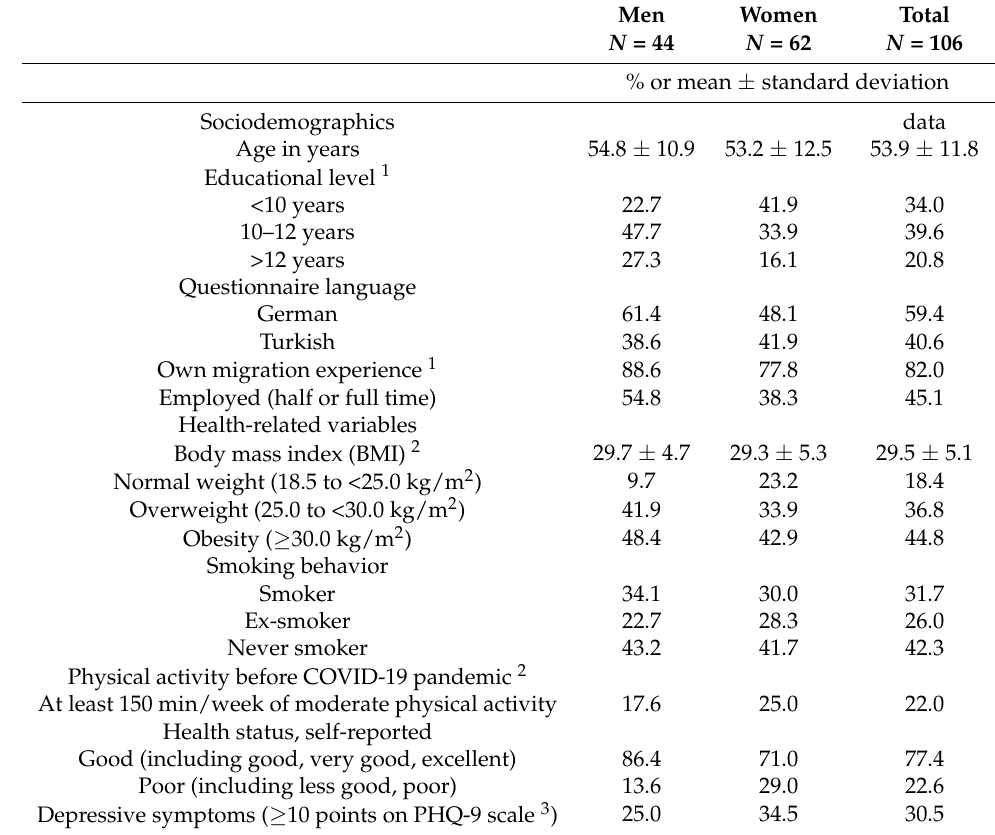
Table 1. Characteristics of the study